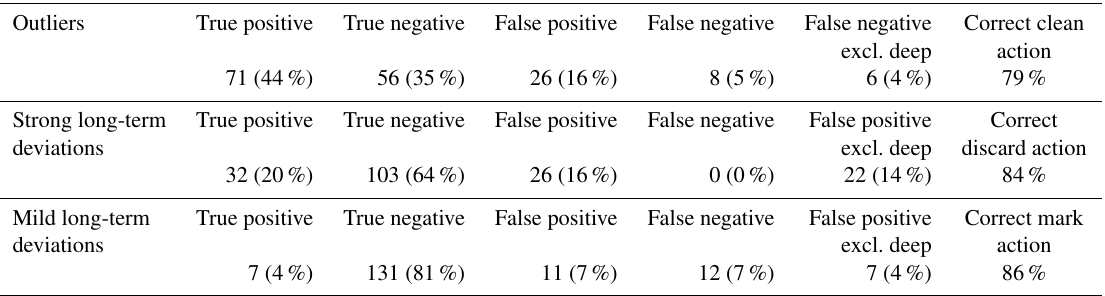
Table 3. Validation performance for the standard parameter set (Table 1). The number of series with insufficient data is 19, so n total = 161. The terms used in the table are as follows: true positive – identified in both manual and automatic validation; true negative – not identified in either manual or automatic validation; false positive – identified in automatic validation but not in manual validation; false negative – identified in manual but not in automated validation; excl. deep – excluding deep-GWL series. The last column shows the percentage of series with outliers and long-term deviations correctly or reasonably identified.